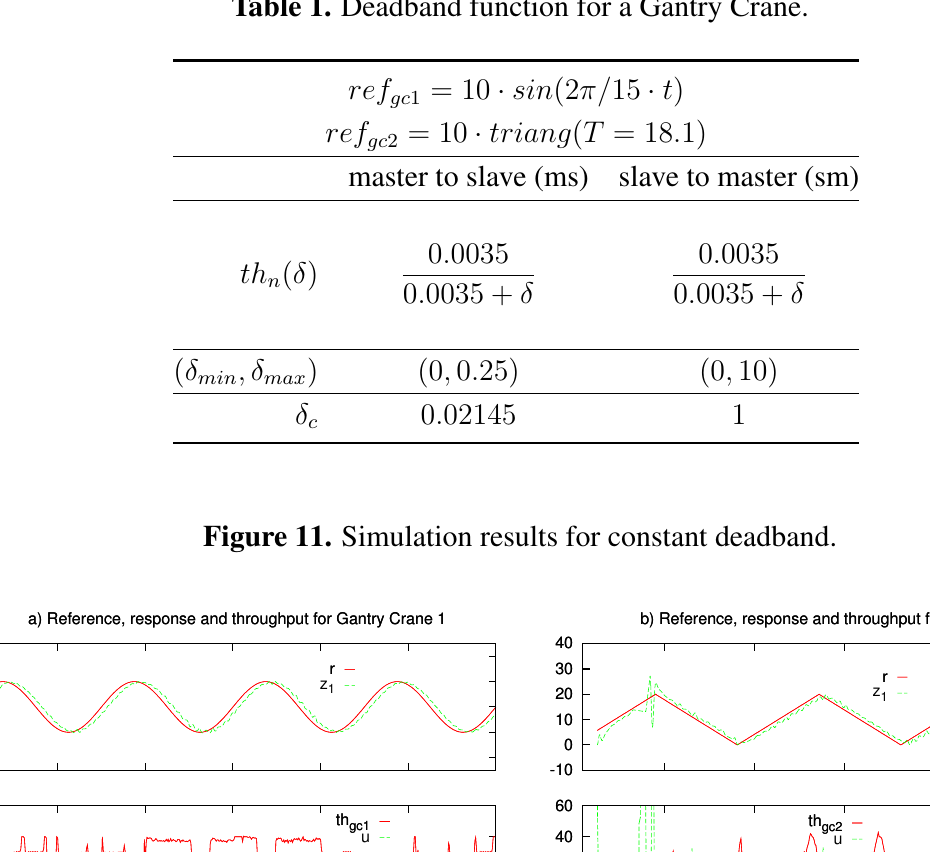
Table 1. Deadband function for a Gantry Crane.